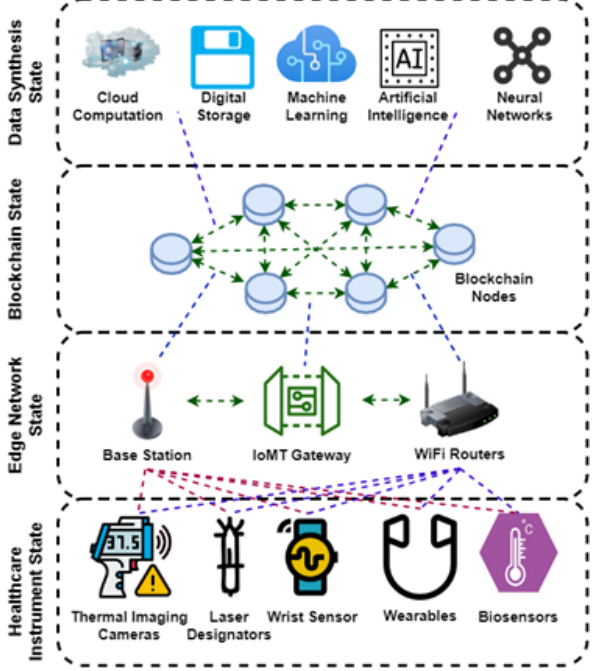
Figure 3. Architecture of Blockchain-Assisted Cybersecurity for IoMT systems. The overall architec- ture is organized into four states, i.e., healthcare instrument state, edge network state, blockchain state, and data synthesis